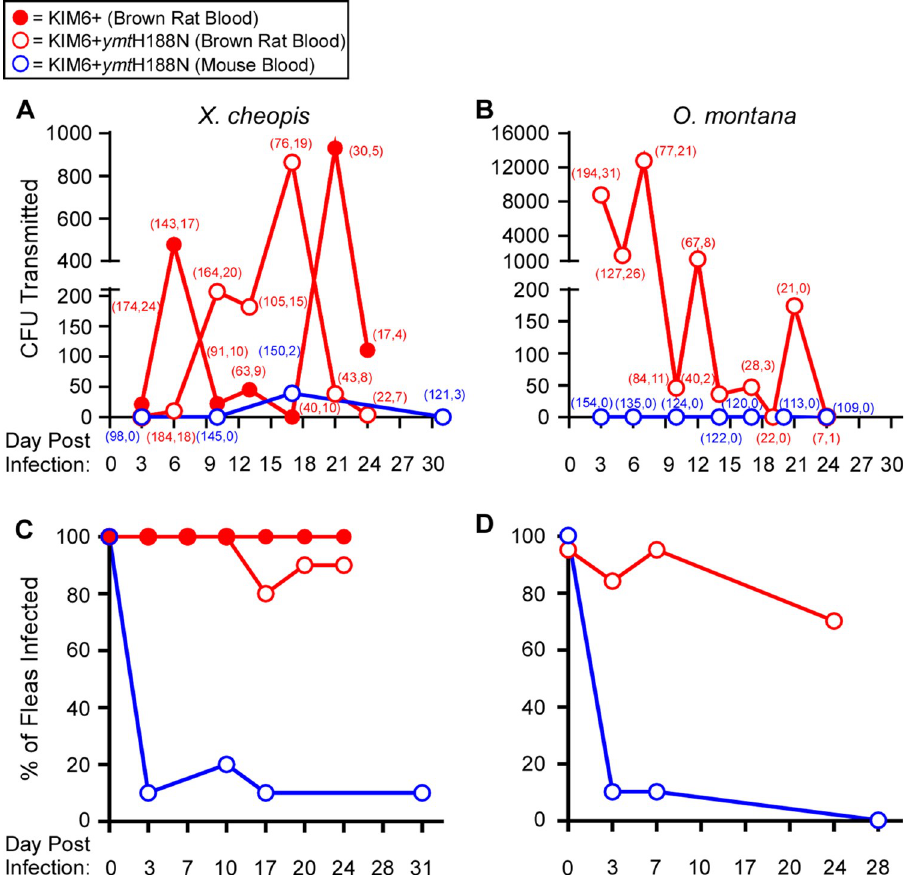
Fig 5. Rodent fleas can transmit Ymt mutant Y . pestis for at least 3 weeks when infected using brown rat blood. Y . pestis transmission dynamics were monitored for 3 to 4 weeks for groups of 150–267 X . cheopis (A) or O . montana fleas infected using 3.4 x 10 8 − 1.9 x10 9 CFU/ml KIM6+ or KIM6+ ymt H188N Y . pestis (B) in either mouse (blue) or brown rat (red) blood and subsequently maintained on sterile blood of the same type. Numbers in parentheses indicate the total number of fleas that fed followed by the number of fleas with evidence of foregut obstruction (partially or fully blocked). Roughly equivalent numbers of male and female fleas were used for transmission assays. Infection rate was determined for groups of 10–20 female C) X . cheopis or D) O . montana at various times following